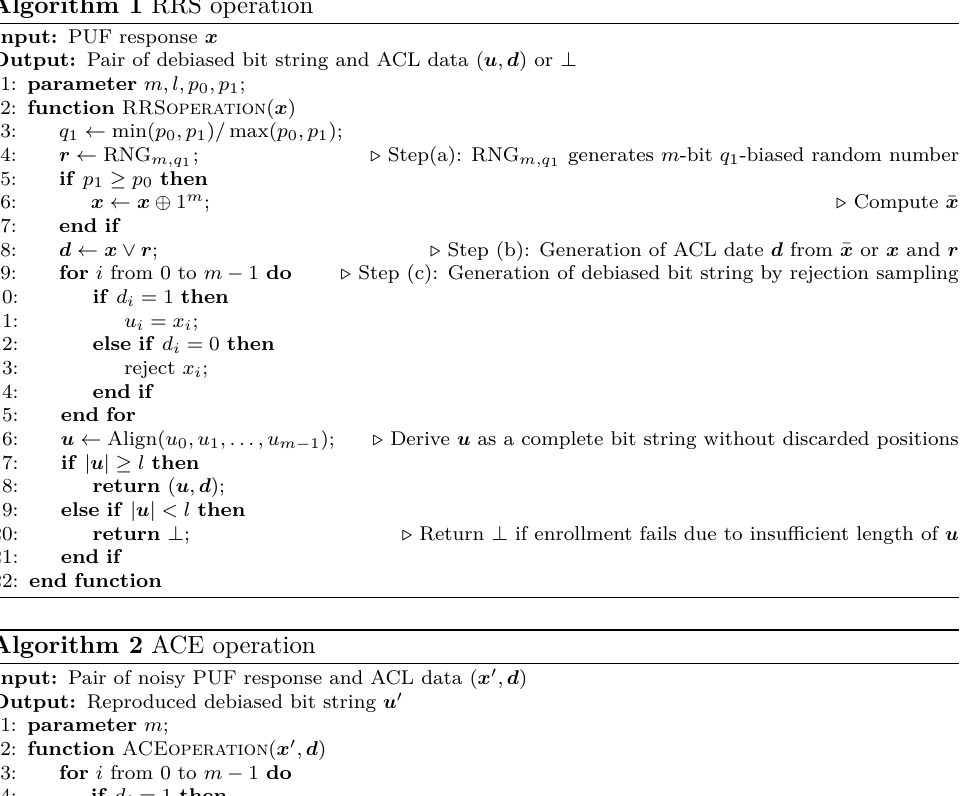
Algorithm 1 RRS operation